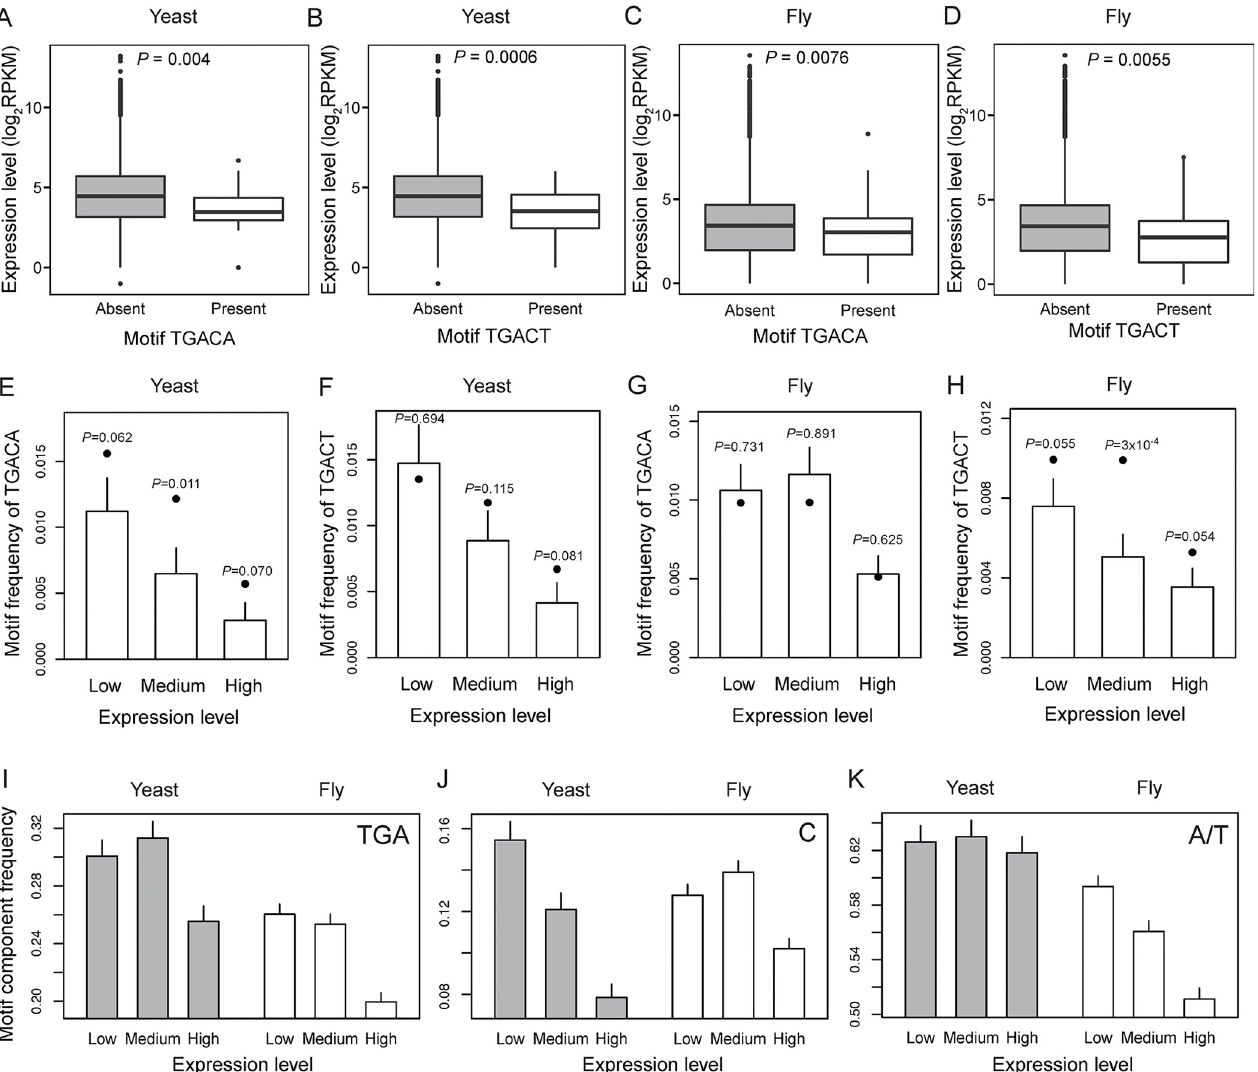
Fig 2. Read-through motifs are avoided in highly expressed genes. “TGACA” and “TGACT” (stop codon underlined) are two previously identified sequence motifs conducive to stop-codon read-through. A total of 6,572 yeast genes and 11,895 fruit fly genes are considered. ( A - D ) Yeast ( A - B ) and fruit fly ( C - D ) genes with and without the read-through motifs show significantly different expression levels. The distribution of gene expression level is shown in a box plot, where the lower and upper edges of a box represent the first (qu 1 ) and third quartiles (qu 3 ), respectively, the horizontal line inside the box indicates the median (md), the whiskers extend to the most extreme values inside inner fences, md ± 1.5(qu 3 -qu 1 ), and the circles represent values outside the inner fences (outliers). P -values are based on Mann-Whitney U tests. ( E - H ) Observed and expected motif frequencies in yeast ( E - F )and fruit fly ( G - H ) genes of low, medium, and high expressions. Genes are ranked by expression levels and then divided into three bins of equal numbers of genes. Each bar shows the observed motif frequency, with the error bar representing the standard deviation based on 1,000 bootstrap samples of genes within the bin. Each dot shows the motif frequency expected from the observed frequencies of the three components (stop codon and each of the following two nucleotides) of the motif in the bin. We shuffled motif components among genes in the same bin 10,000 times, and the P -value above each dot shows the probability that the number of motifs observed upon a shuffle is equal to or smaller than the number in the actual genes. ( I - K ) Frequencies of the stop codon TGA ( I ), C following the stop codon ( J ), and A/T at the next position ( K ) in yeast (grey bars) and fruit fly (white bars) genes of low, medium, and high expressions. Error bars show standard deviations based on 1,000 bootstrap samples of genes within the bin. Note that the Y-axis does not start from 0 in